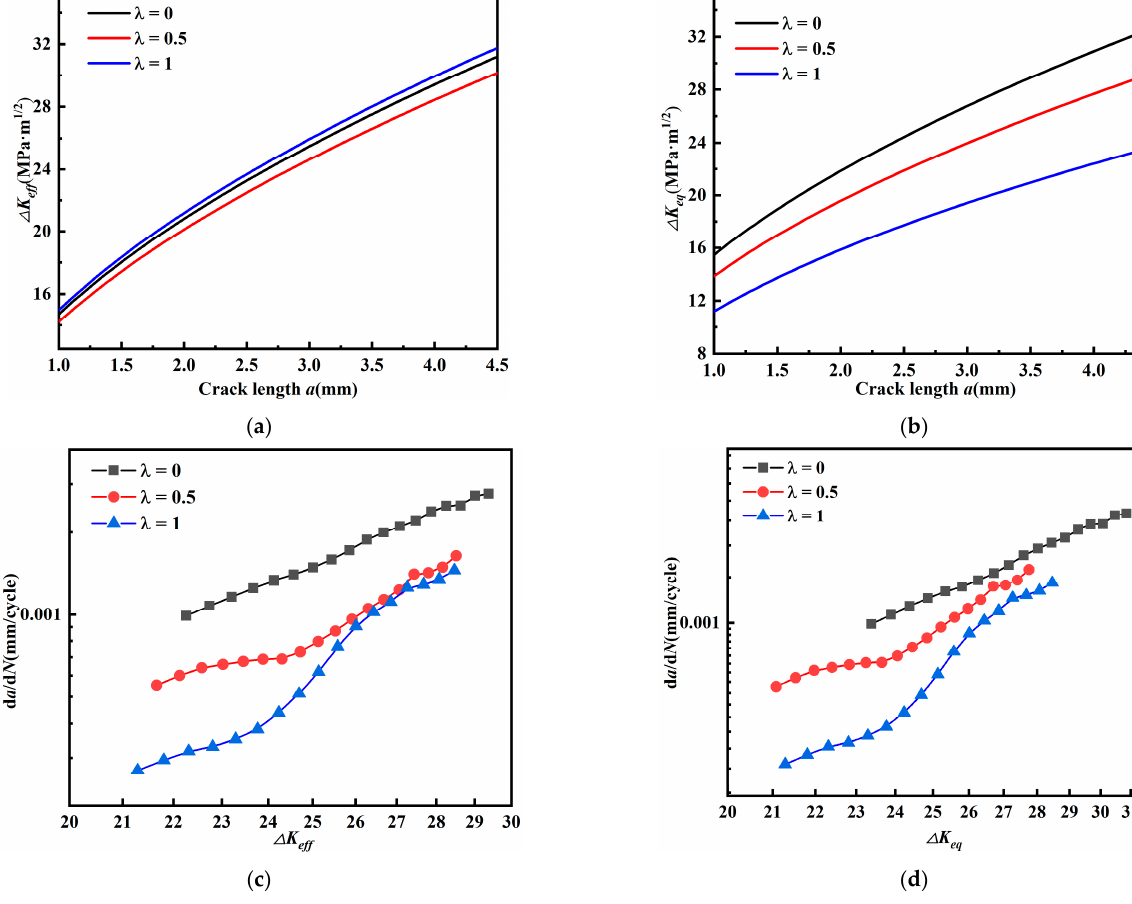
Figure 12. Relationship between crack length, equivalent and effective stress intensity factor ampli- tude, and da/dN ( β =60°). ( a ) Relationship between a and △ K eff , ( b ) relationship between a and △ K eq , tude, and da/dN ( β = 60 ◦ ). ( a ) Relationship between a and ∆ K eff , ( b ) relationship between a and ∆ K eq , ( c ) relationship between △ K eff and da/dN , and ( d ) relationship between △ K eq and da/dN . ( c ) relationship between ∆ K eff and da/dN , and ( d ) relationship between ∆ K eq and da/dN